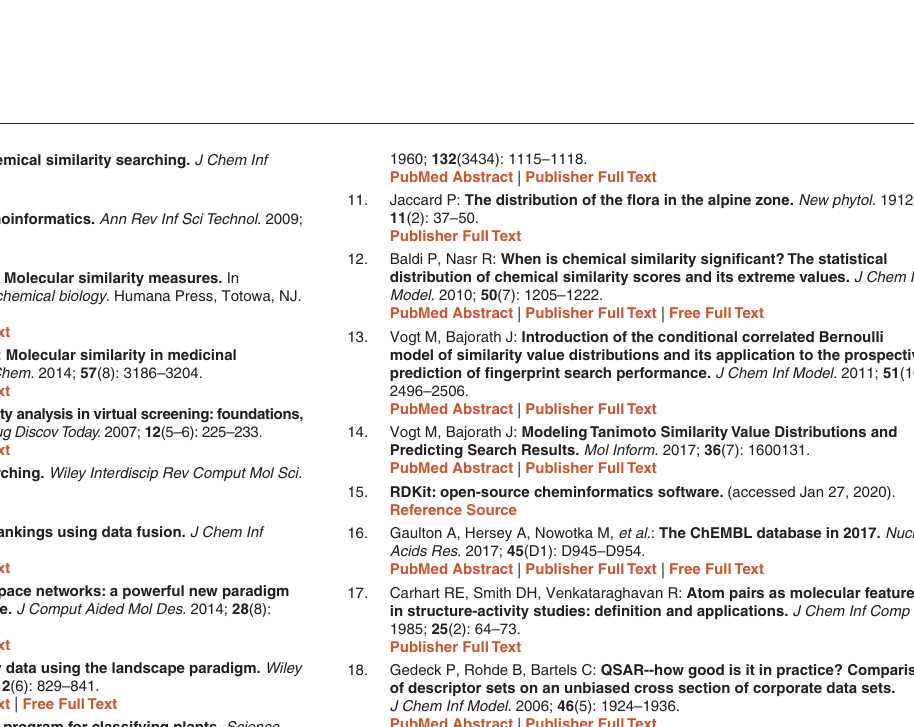
The Python code used for data generation, data analysis, and generation of the figures is available in form of a Jupyter notebook in the GitHub repository 27